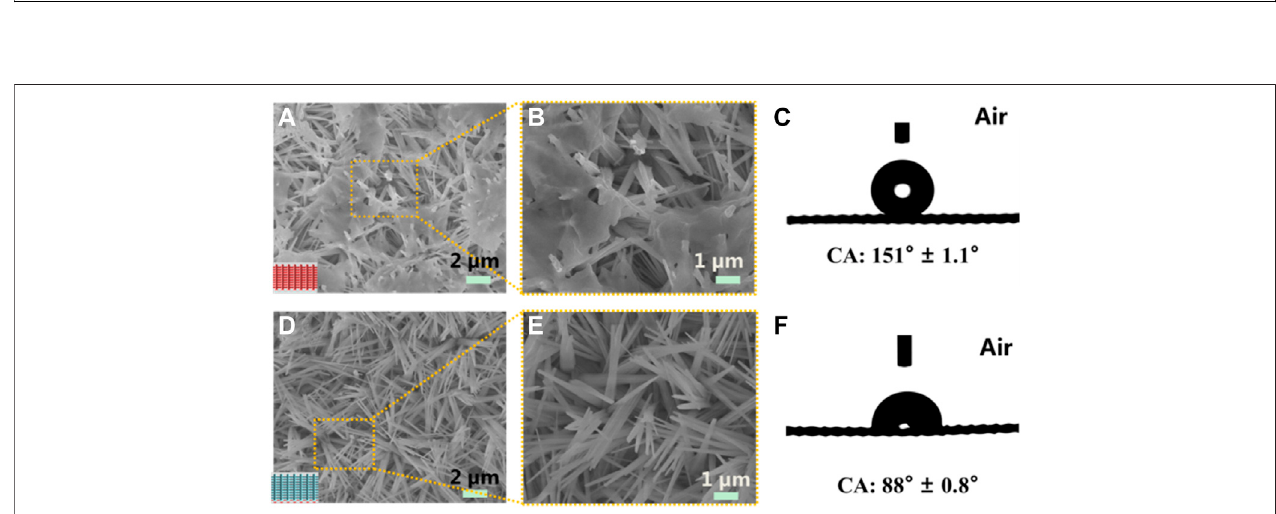
FIGURE 1 | The schematic of the fabrication procedure of single-layer Janus CM. (A) Pre-cleaned CM. (B) The etched CM with superhydrophobicity. (C) Single- layer modi fi cation of CM by a water wetting-controlled strategy. (D) A Janus CM with hydrophilic/superhydrophobic after FAS modi fi cation.